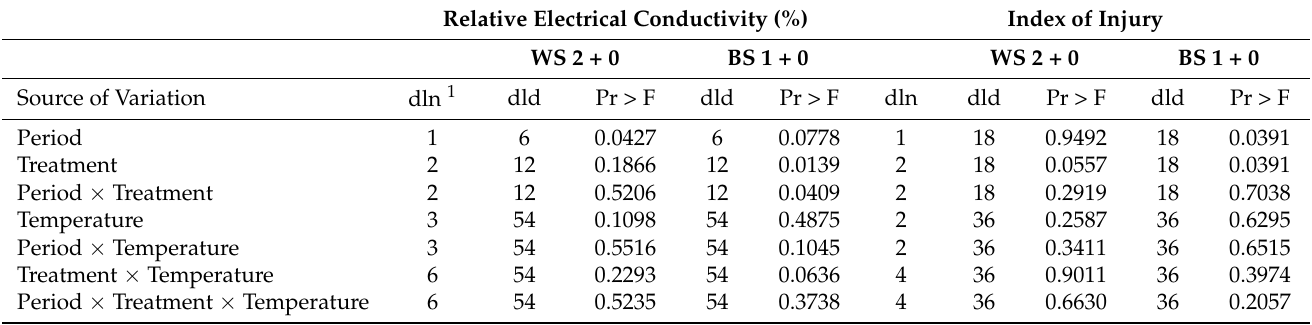
Table 4. Observed probabilities (Pr > F) and degrees of freedom of the fixed effects associated with the analysis of variance of the relative electrical conductivity (RC) and index of injury (It) of shoots of two-year-old white spruce (WS, 2 + 0) and one-year-old black spruce (BS, 1 + 0). Relative Electrical Conductivity (%) Index of Injury WS 2 + 0 BS 1 + 0 WS 2 + 0 BS 1 + 0